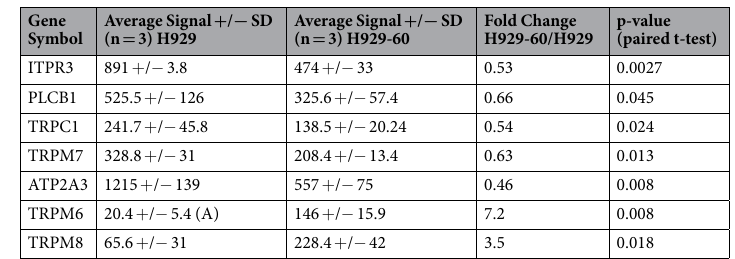
Table 1. Microarray gene expression profiling of NCI-H929 and H929-60 cells. The mean expression values of the three independent experiments were compared between NCI-H929 and H929-60 cell lines. Fold change was calculated by ratio between NCI-H929 H929-60 cell